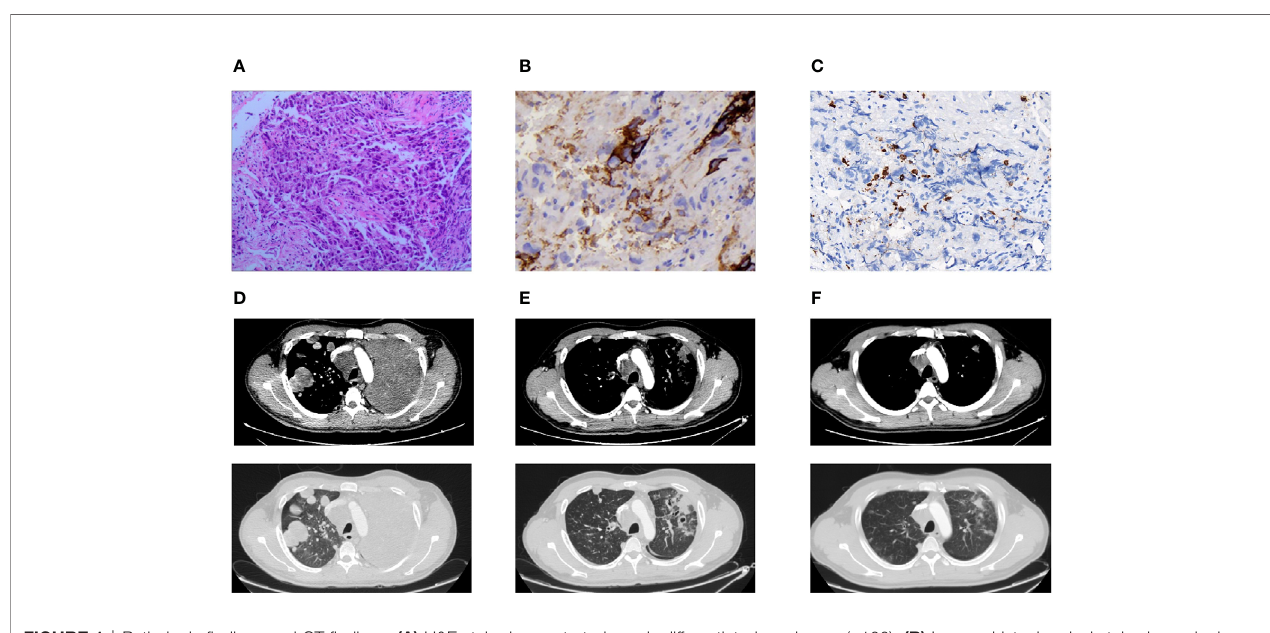
FIGURE 1 | Pathologic fi ndings and CT fi ndings. (A) H&E stain demonstrated poorly differentiated carcinoma (×100). (B) Immunohistochemical stain showed a low positive PD-L1 expression of TPS 5 – 10% (×400). (C) Immunohistochemical stain indicated a low CD8(+) TIL density of 147.91 psc/mm² (×400). (D) Pulmonary lesions progressed in CT chest after one cycle of chemotherapy. (E) Pulmonary lesions lessened after two cycles of chemo-immunotherapy. (F) Pulmonary lesions shrunk after four cycles of chemo-immunotherapy.